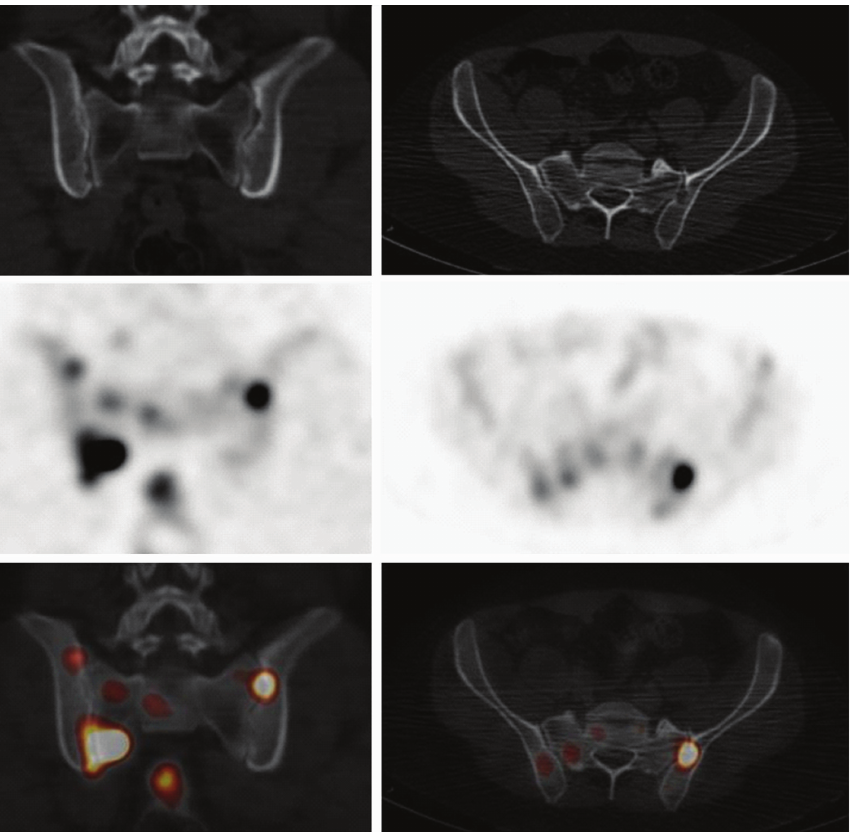
Figure 3: The figure shows sacroiliac joint involvement as hypermetabolic lesions as seen on 18 F-FDG-PET/CT. Left row: coronal CT, PET, and fused PET/CT slices. Right row: transverse CT, PET, and fused PET/CT